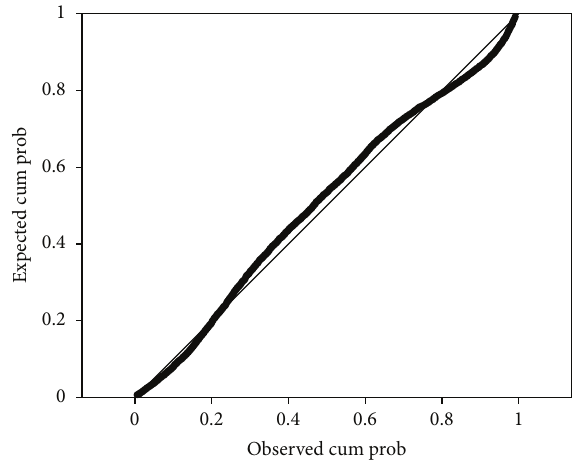
Figure 5: Normal probability plot.